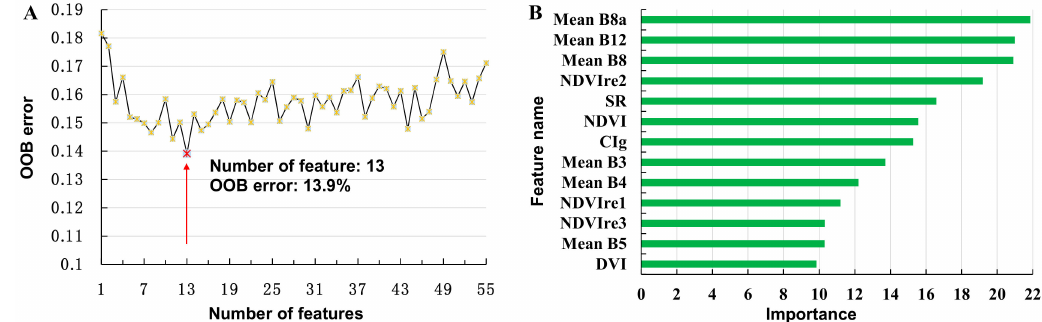
Figure 4. The optimal number and important features. ( A ) The out-of-bag (OOB) errors and ( B ) feature importance of the top 13 features.